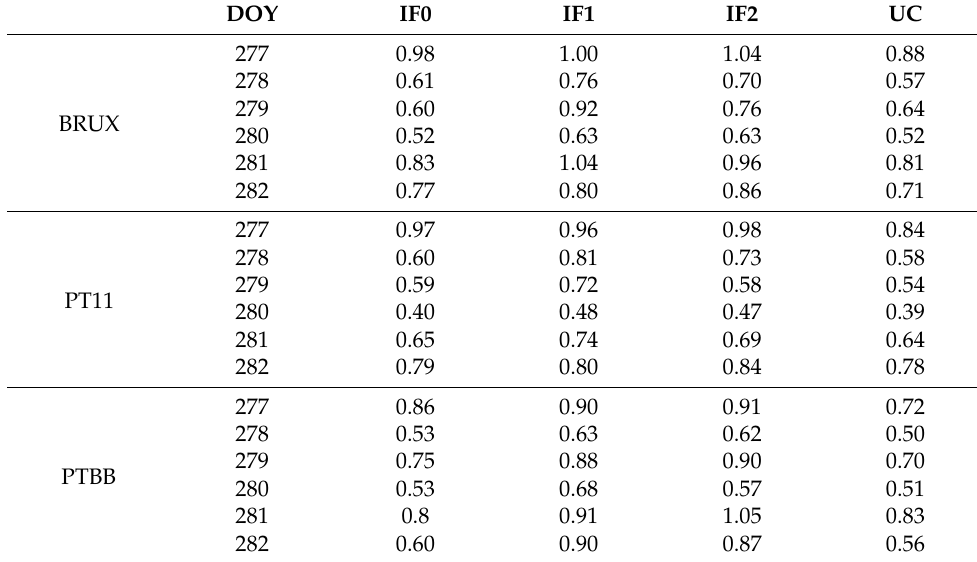
Table 10. The RMS values of ZTD errors for BRUX, PT11, and PTBB stations with different Galileo PPP models